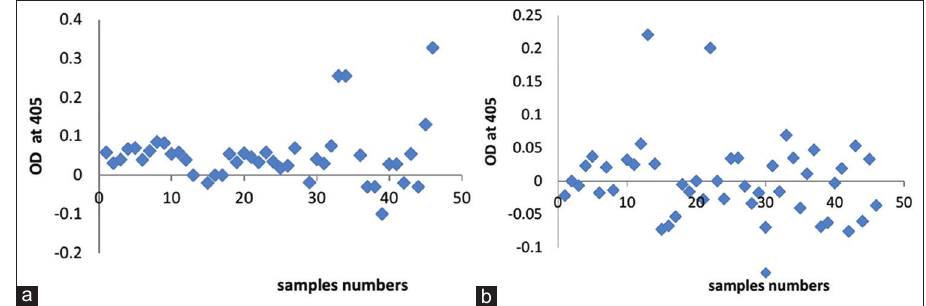
Figure-1: (a) Scattered graph represents diagnostic potential of Toxocara vitulorum cuticle N-acetyl glucosamine isolated fraction. (b) Scattered graph represents diagnostic potential of T. vitulorum cuticle glucose isolated fraction.